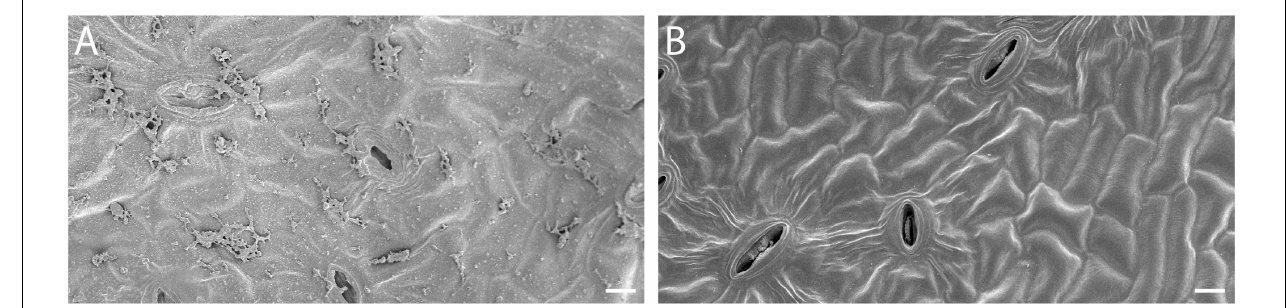
FIGURE 1 | Removal of surface microbes from almond leaves (A) Before and (B) after surface sterilization. Scale bar = 10 µ m.